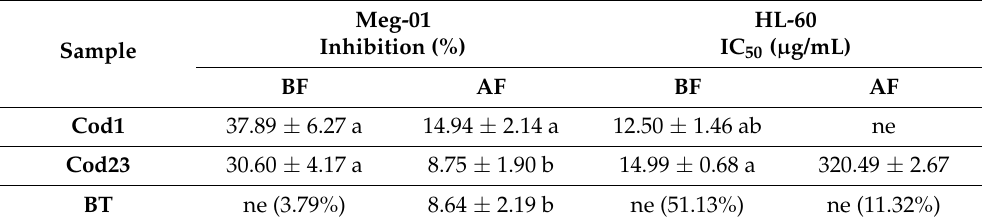
Table 3. Effect of kombucha fermentation on cytotoxic